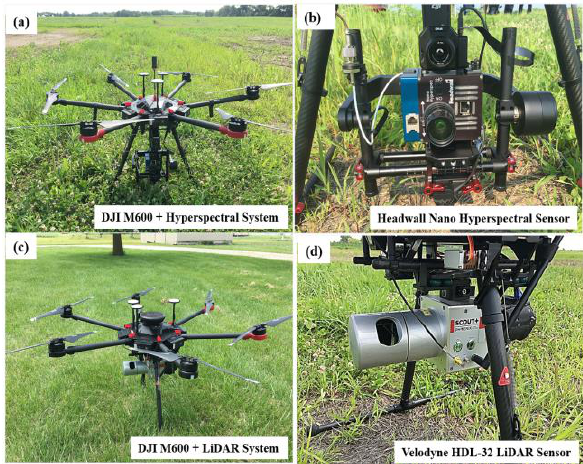
Figure 1. Platforms and sensors are used for collecting high- resolution hyperspectral and multispectral images.